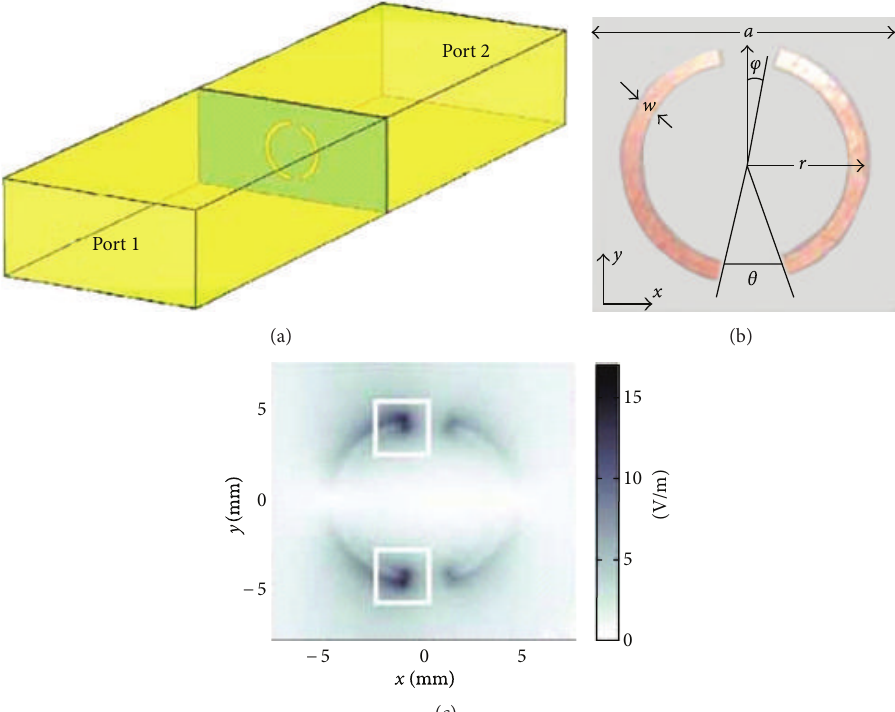
Figure 15: (a) Schematic view of the aDSR-assisted sensor. (b) Layout of the circular aDSR. (c) Simulated spatial field distribution for the aDSR [58].